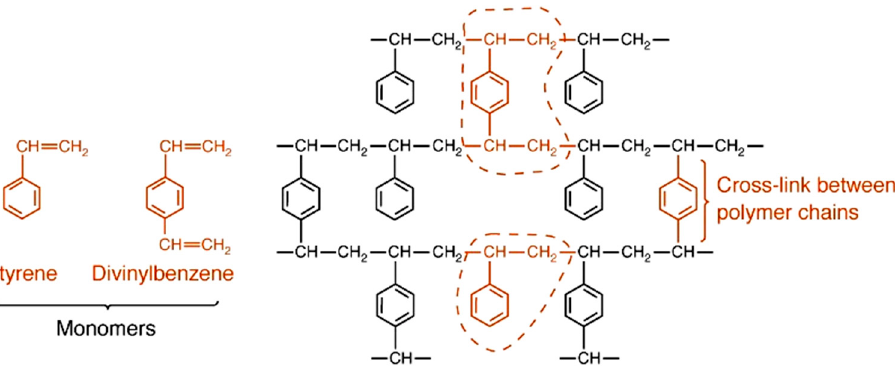
Figure 1. Synthesis of ST-DVB ion exchanger.